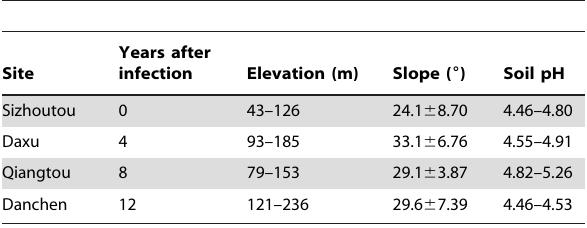
Figure 1. Map and photos of the study sites in Xianshan County, Zhejiang Province, East China. Sizhoutou: exposure to PWD 0 year stand, Daxu: 4 year stand, Qiangtou: 8 year stand, and Danchen: 12 year stand. doi:10.1371/journal.pone.0036432.g001 Table 1. Characteristics of the four study sites in Xianshan County, Zhejiang Province, East